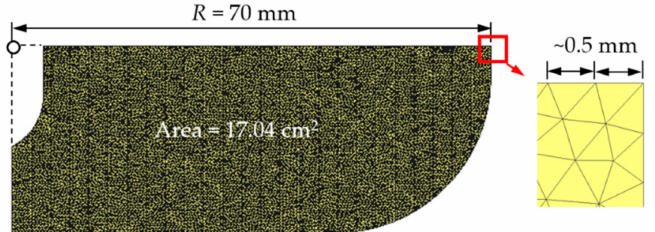
Figure 9. Mesh on the wing surface. The white circle marks the pivot point.